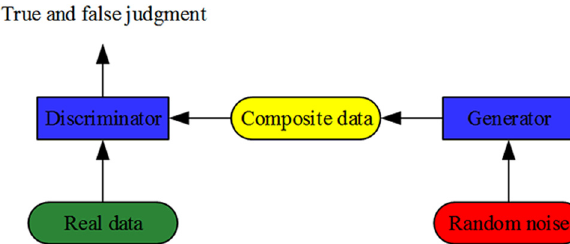
Figure 2: General calculation fl ow of countermeasure